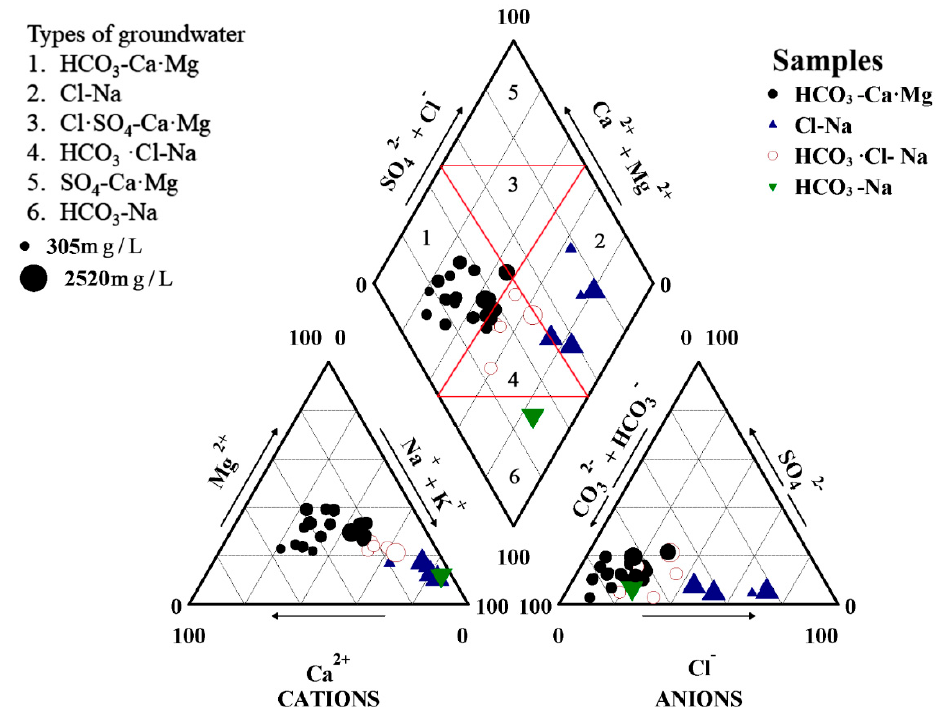
Figure 2. Piper diagram of shallow groundwater. The size of symbols represents the TDS (total dissolved solids).